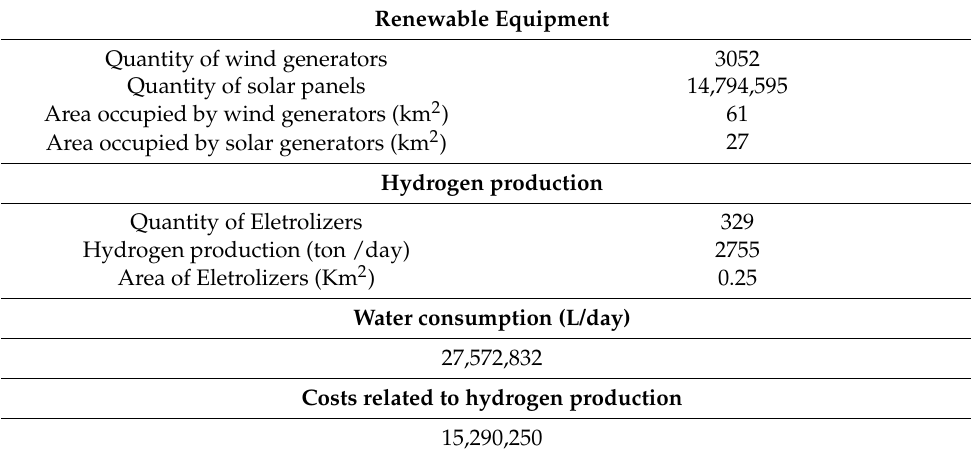
Table 11. Aggressive scenario